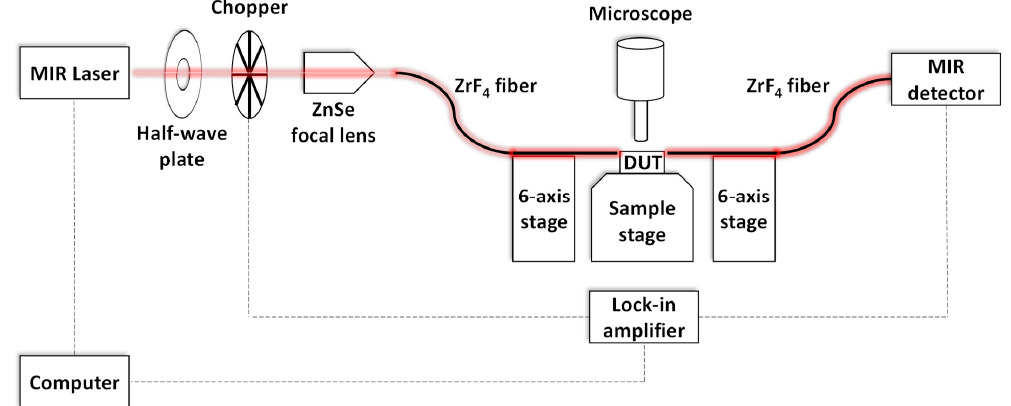
Figure 3. Experimental setup for optical testing. The dashed lines and glowing lines show the equipment connection and light path respectively.